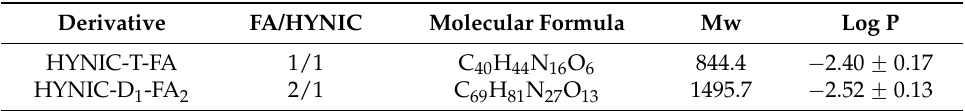
Table 1. Molecular parameters of HYNIC-T-FA and HYNIC-D 1 -FA 2